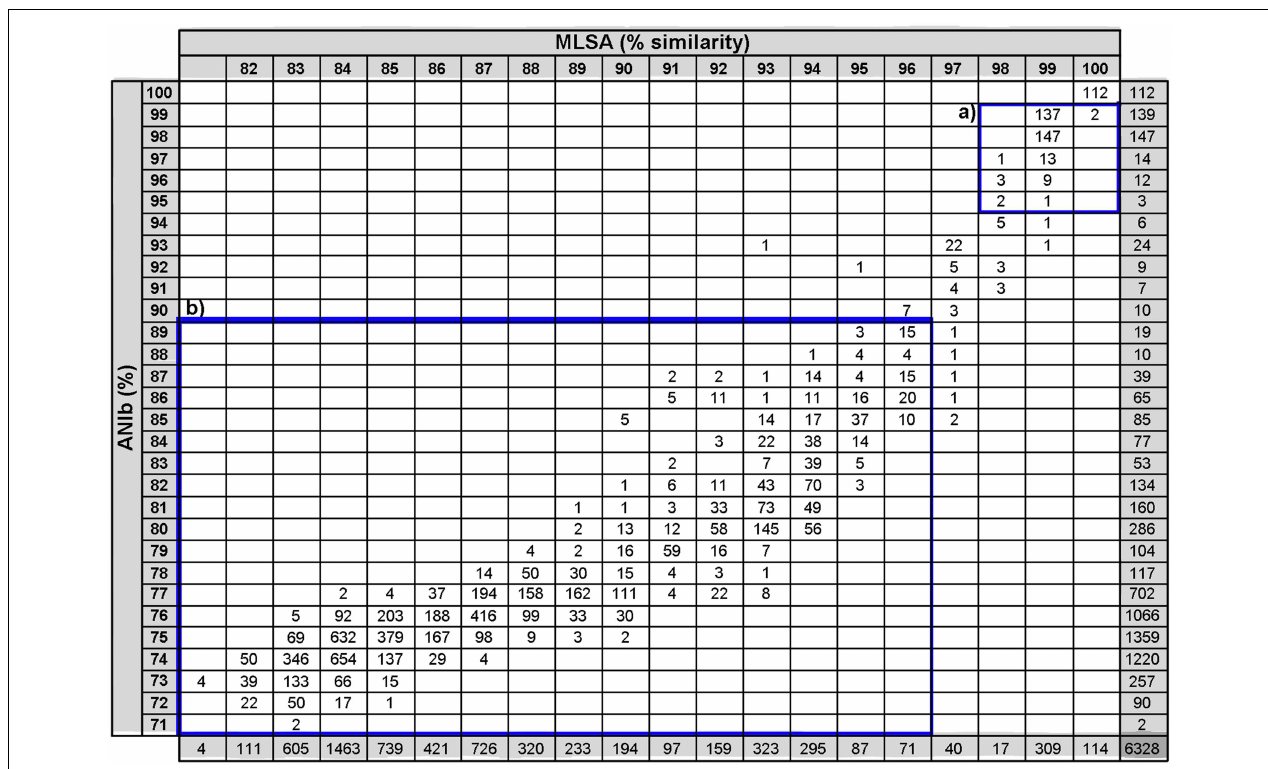
FIGURE 3 | Association table between ANIb values and MLSA sequence similarities. The number of strain pairs is displayed in each category square. Square A indicates ANIb values ≥ 95% and MLSA ≥ 97%; square B indicates ANIb values < 90% and MLSA values <